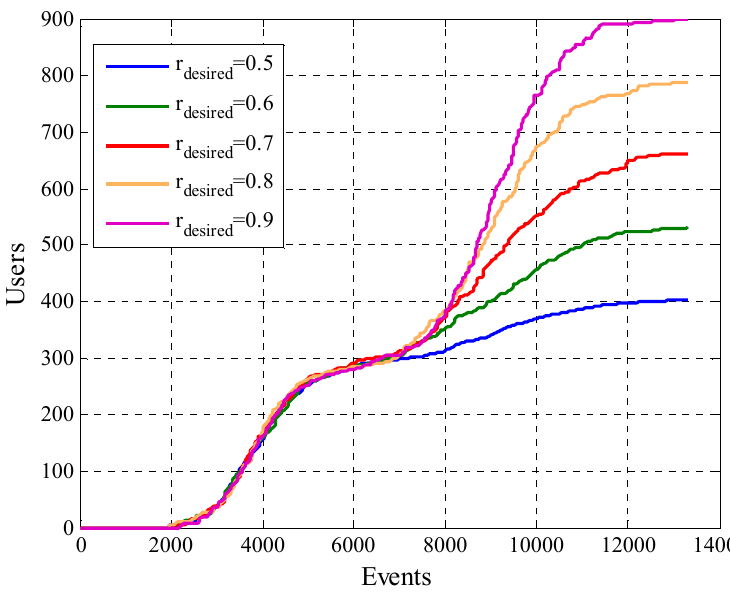
ff erent values of r desired .